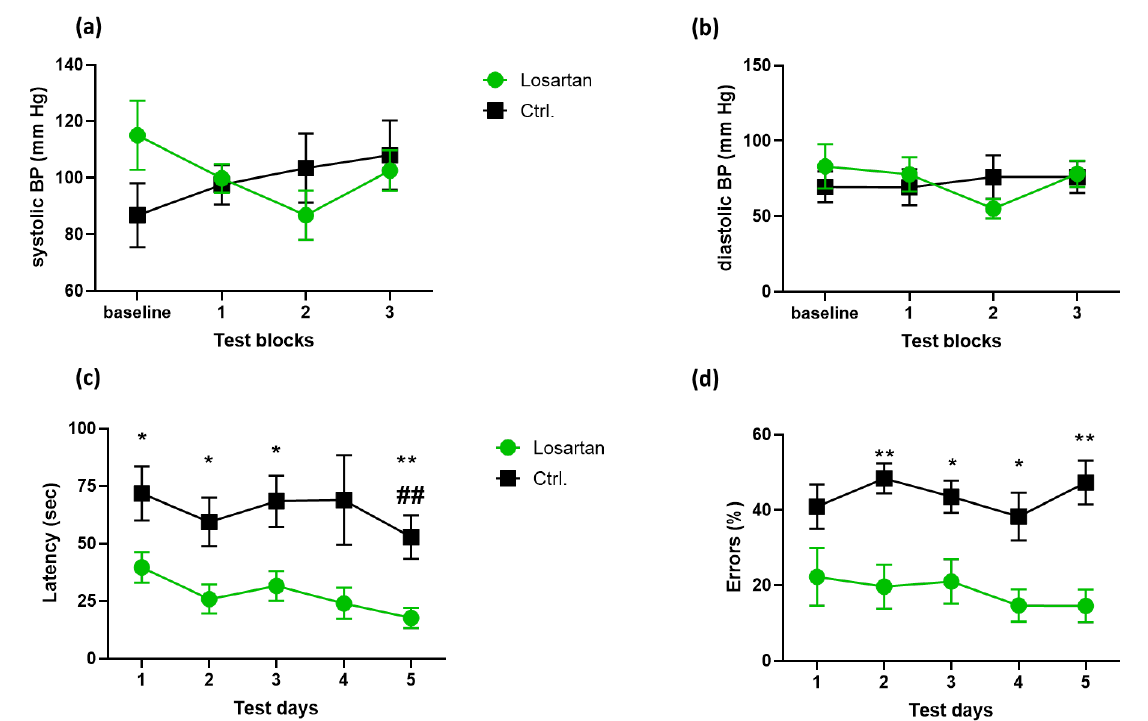
Figure 1. Blood pressure (BP) and cognitive performance of losartan and vehicle treated APP/PS1 mice. Seven-month-old APP/PS1 mice ( n = 9 in losartan and n = 8 in control group) were assessed for blood pressure and spatial working memory in losartan and vehicle treated (Ctrl.) groups. ( a , b ) systolic and diastolic blood pressure measured prior (baseline) and during drug (vehicle treatment (test blocks 1–3); ( c ) Latency to reach the goal arm and ( d ) number of incorrect choices in forced choice alternation T-maze assessed at the last 5 days of losartan or vehicle treatment. ( c , d ) Two-way ANOVA with Holm Sidak’s multiple comparisons test p < 0.05 (*), p < 0.01 (**) comparison between losartan and Ctrl. group; (##) comparison between day 1 and day 5 within the losartan-treated group.